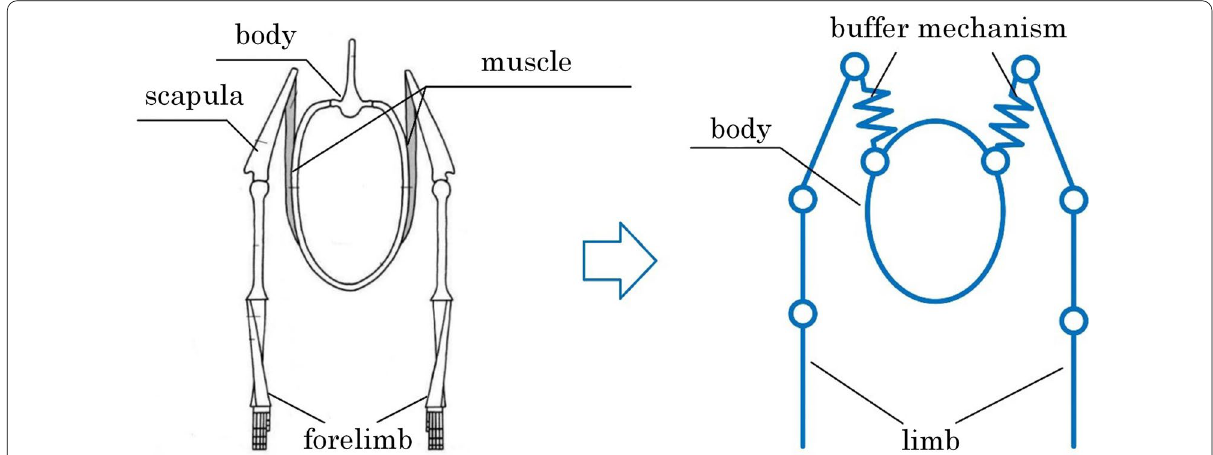
Figure 7 Bionic mapping of the shoulder (hip) buffer